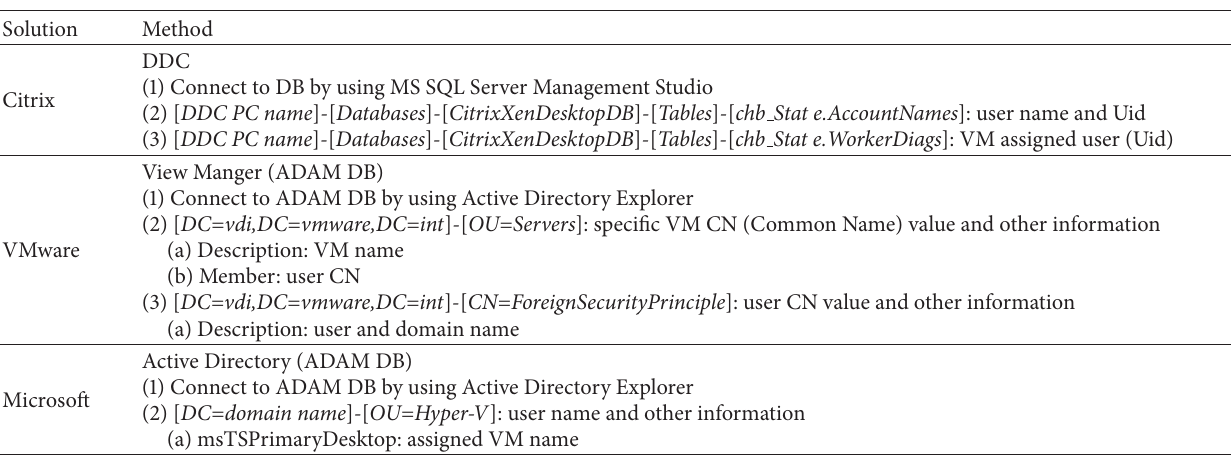
Table 7: Method of finding assignment information in the database of the connection or authentication management system.